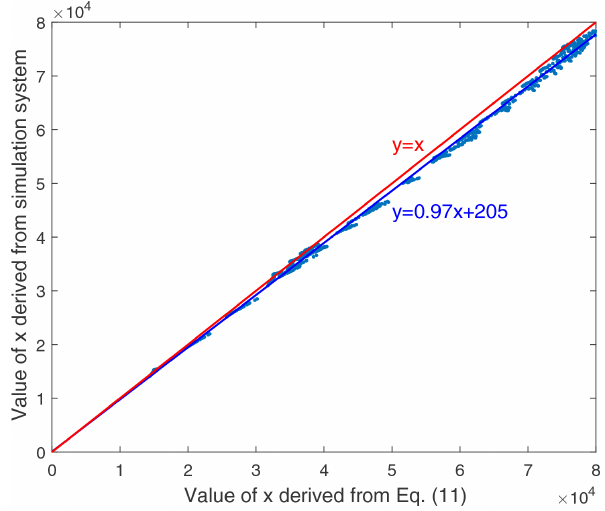
Figure A3. The scatter plot of the x values which are derived from Eq. (11) and simulation system, and x is the sum of N A and N B